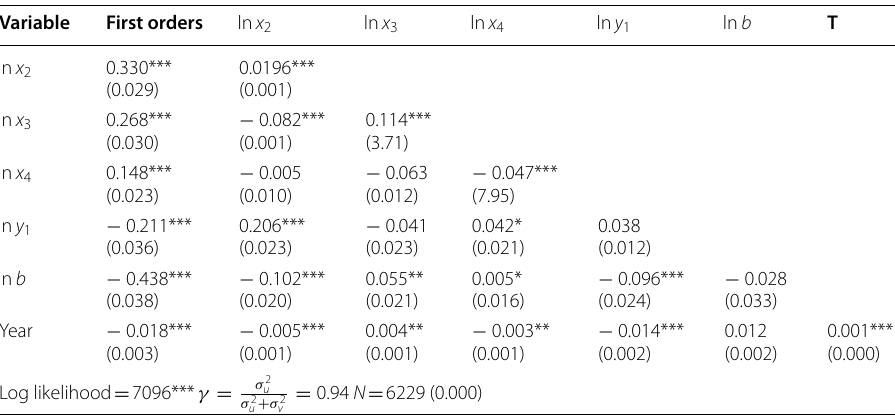
Table 2 Parameter